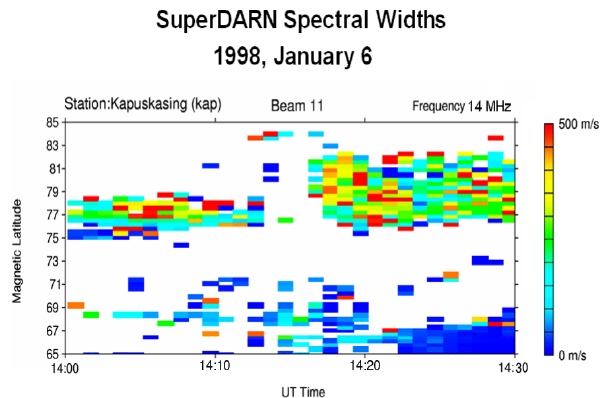
Fig. 8. SuperDARN spectral widths measured as a function of magnetic latitude between 14:00 and 14:30UT for beam 11 of Ka- puskasing